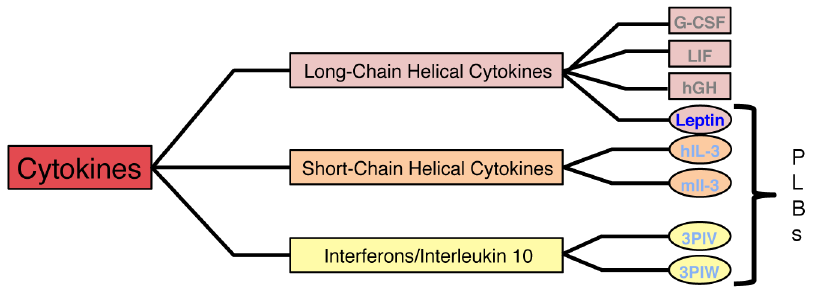
Figure 3. Schematic view of the helical cytokine sub-family. The cytokine sub-family (red) is divided into three families: The long-chain helical cytokines (pink), the short-chain helical cytokines (orange) and interferons/interleukin 10 (yellow). The overall topology within the cytokines is conserved with differences in length and topology, where the interferons and interleukin 10 have two extra helices outside the four-helix bundle and the long-chain and short-chain helical cytokines have one extra helix. The figure shows the proteins discussed in the text, where threaded motifs (PLBs) are circled and unthreaded proteins are boxed. We note that there are many unthreaded examples as well as a few PLB proteins in each family, not shown in this